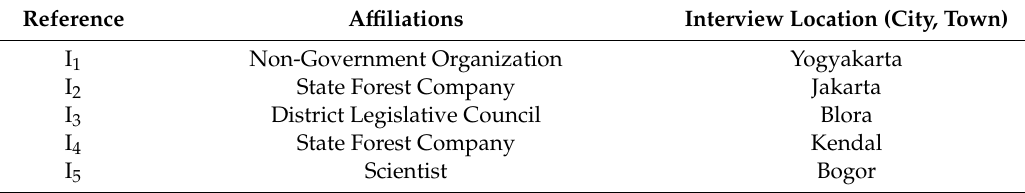
Table A1. List of Informants’ A ffi liation and Location of